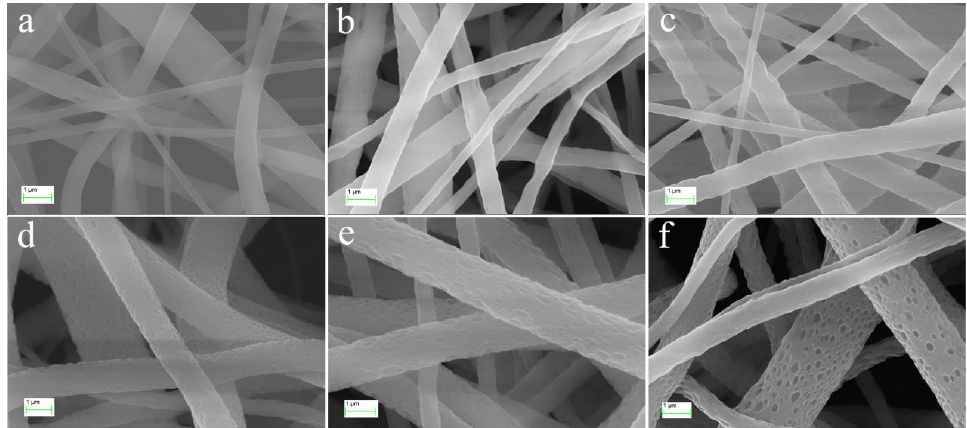
Figure 2. SEM images of AuNPs coated PEI / PCL electrospun fibers with di ff erent weight ratios ((w / w) ( a ), 10:90; ( b ), 15:85; ( c ), 20:80; ( d ), 25:75; ( e ), 30:70; ( f ), 35:65).